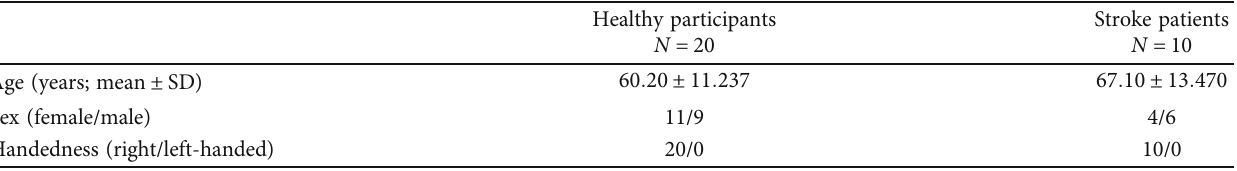
Table 1: Demographic data of volunteers.